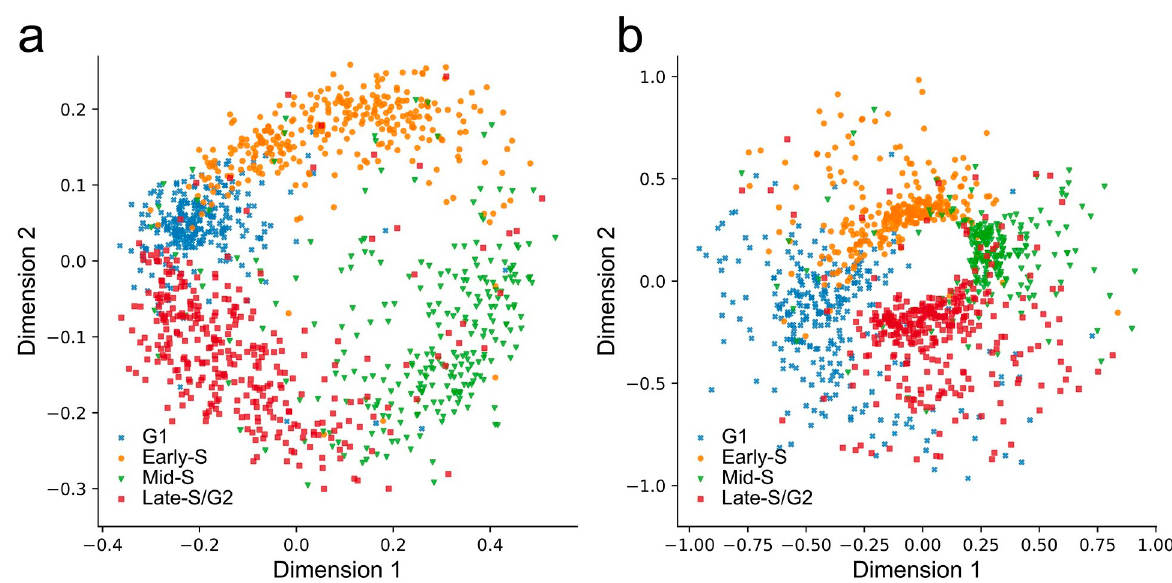
Fig 4. Two-dimensional embedding using different dimension reduction methods. (Dataset: Nagano et al., 2017). (a) Two-dimensional projection from InnerProduct/PHATE shows a circular pattern similiar to MDS projection (ACROC: 0.920). (b) Two-dimensional projection from InnerProduct/ t -SNE shows a circular pattern (ACROC: 0.901).